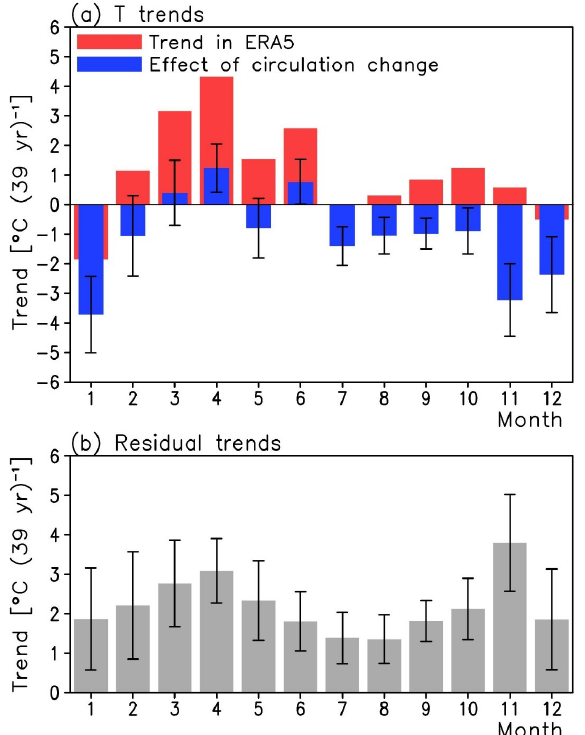
Figure 3. Linear trends of monthly mean temperature in West Siberia (55–65 ◦ N, 65–90 ◦ E) in the years 1979–2018. In (a) , the red bars show the trend in the ERA5 reanalysis and the blue bars the circulation-related trend. In (b) , the residual trends are shown. The error bars indicate the 5%–95% uncertainty range in the circulation-related trend and the residual trend based on inter- annual variability. Redrawn from Räisänen